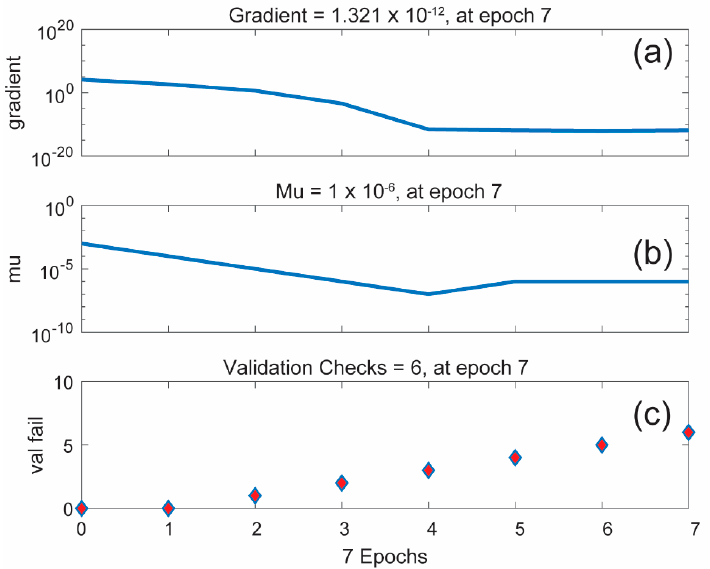
Figure 9. Performance curve for predicting NO x conversion percentage, X.